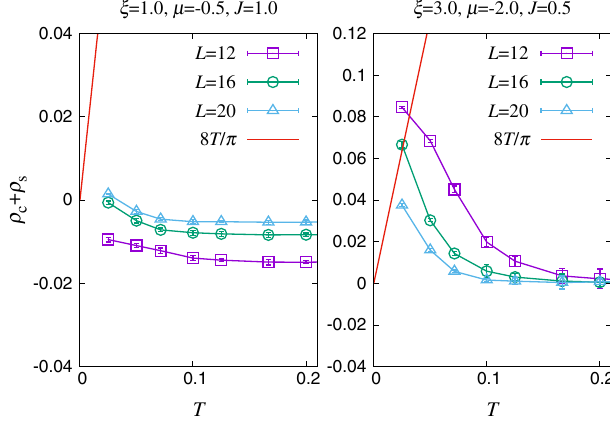
FIG. 10. Phase diagram of the phase action Eq. (F2), illustrating the SN phase, the charge-4e SC phase, and the triplet super- conducting phase.